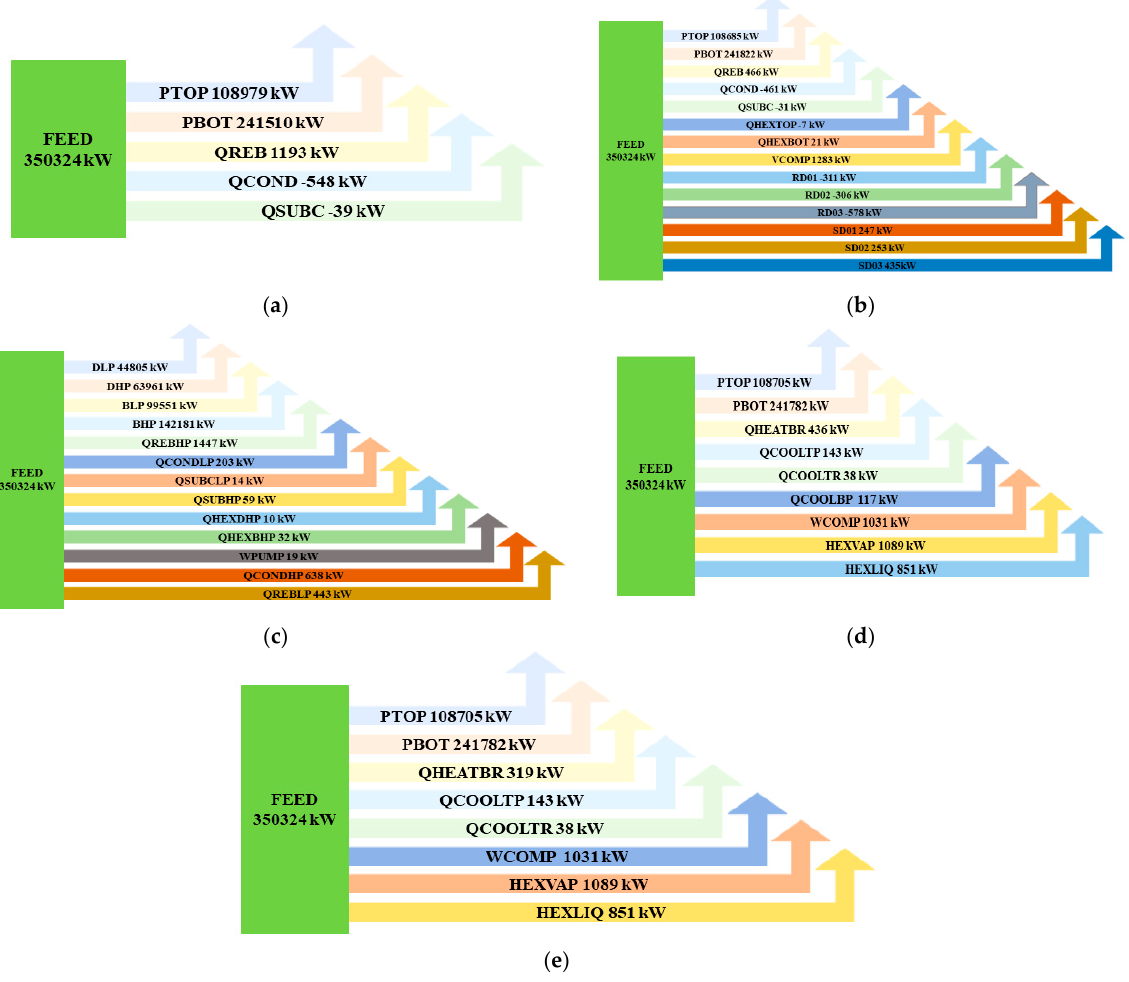
Figure 6. Exergy flow diagrams of ( a ) CDC, ( b ) iHIDiC, ( c ) EHIDIC, ( d ) VRC, and ( e ) Modified VRC. Table 8. A comparison of the exergy efficiencies of various heat-integrated